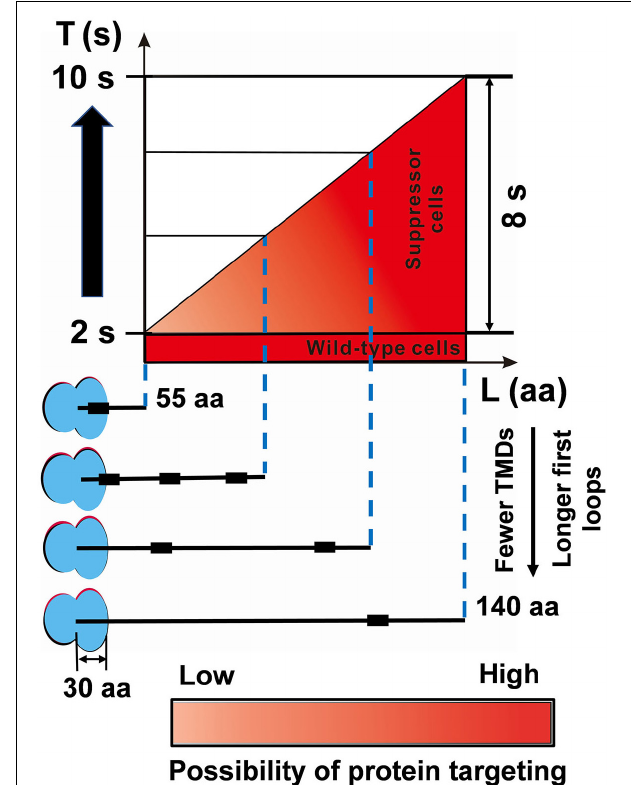
FIGURE 5 | The SRP suppressor extends the time window for protein targeting. In wild-type MG1655 cells, although the critical length (L) of inner membrane proteins is variable, the targeting time (T) is fast ( ∼ 2 s). The suppressor cells with a slower elongation rate extended the time window for protein targeting to 2–10 s. For details and references, see section